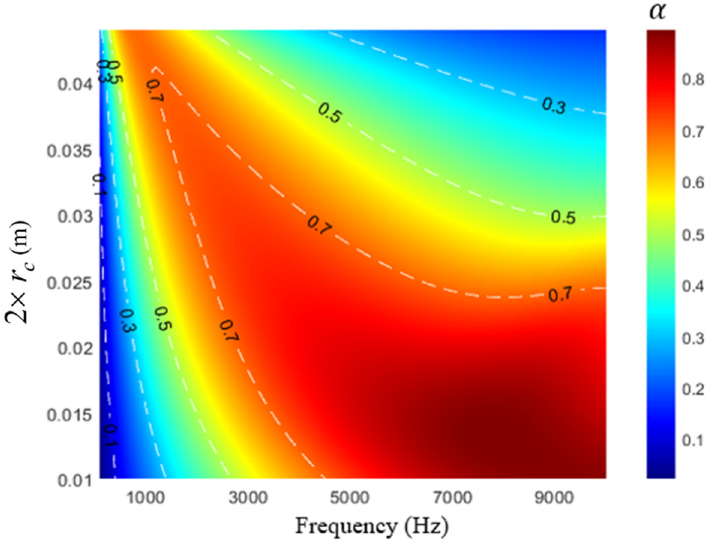
Figure 11. Influence of cavity diameters on contour sound absorption.